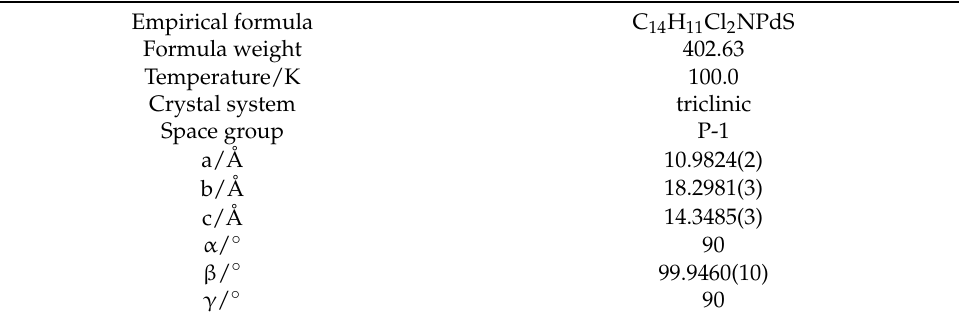
Figure 4. Intermolecular interaction Cl ... . H ... . C(5) of molecular structure ( 1c ). Table 1. Crystal data and structure refinement for 1c .